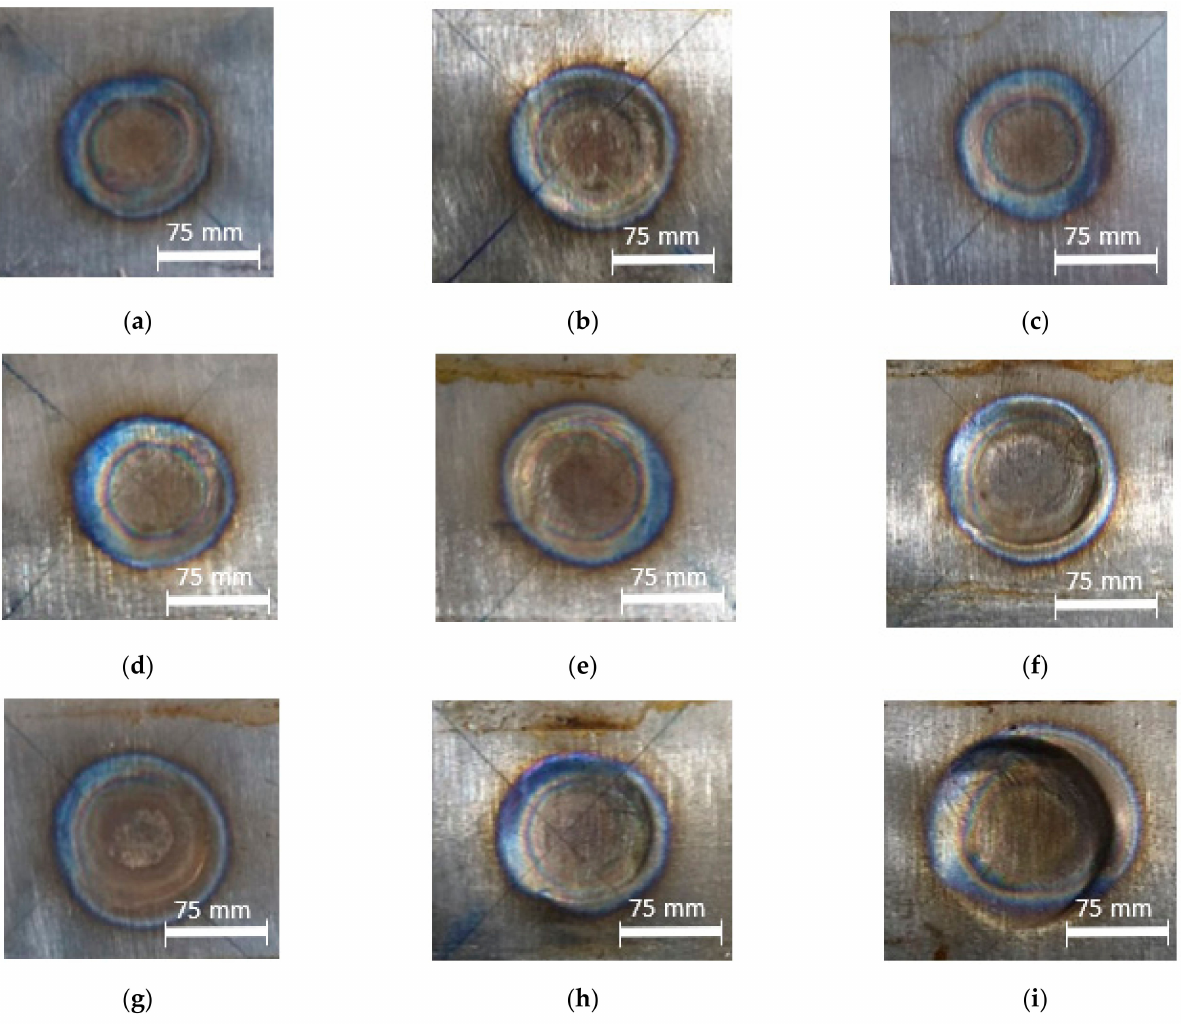
Figure 3. Weld nuggets at RSW parameters: ( a ) 8 kA, 28 cycles, and 3 kN; ( b ) 8 kA, 30 cycles, and 4 kN; ( c ) 8 kA, 32 cycles, and 5 kN; ( d ) 9 kA, 28 cycles, and 4 kN; ( e ) 9 kA, 30 cycles, and 5 kN; ( f ) 9 kA, 32 cycles, and 3 kN; ( g ) 10 kA, 28 cycles, and 5 kN; ( h ) 10 kA, 30 cycles, and 3 kN; ( i ) 10 kA, 32 cycles, and 4